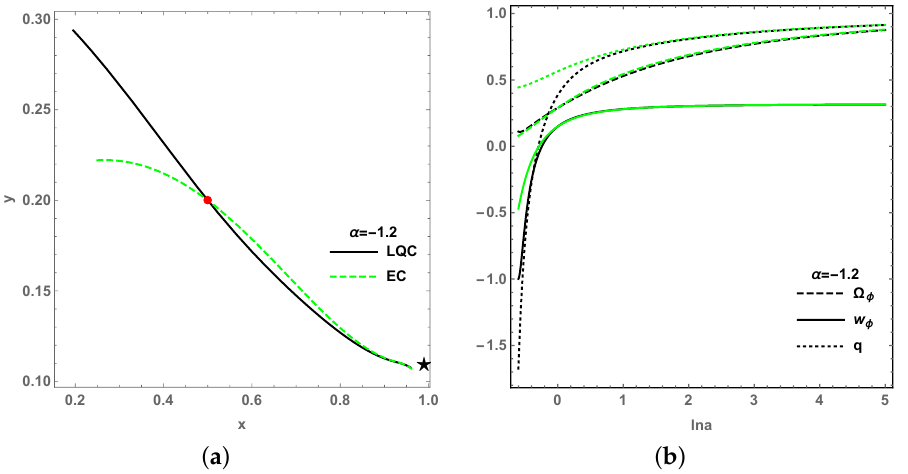
Figure 14. ( a ) The x - y phase plane projected from 3-dim system of { x , y , z } for both LQC(black) and EC(green) around P g , corresponding to the parameters of γ k = 4 , s = 4 and α = − 1.2. The initial 3 points are ( 0.5,0.2,0.1 ) for LQC, and ( 0.5,0.2,0 ) for EC. The star stands for the final state of the evolution, while the solid circle stands for the initial point. ( b ) the evolution of the cosmological quantities of Ω φ , w φ and q for both LQC(black) and EC(green) cases for P g .